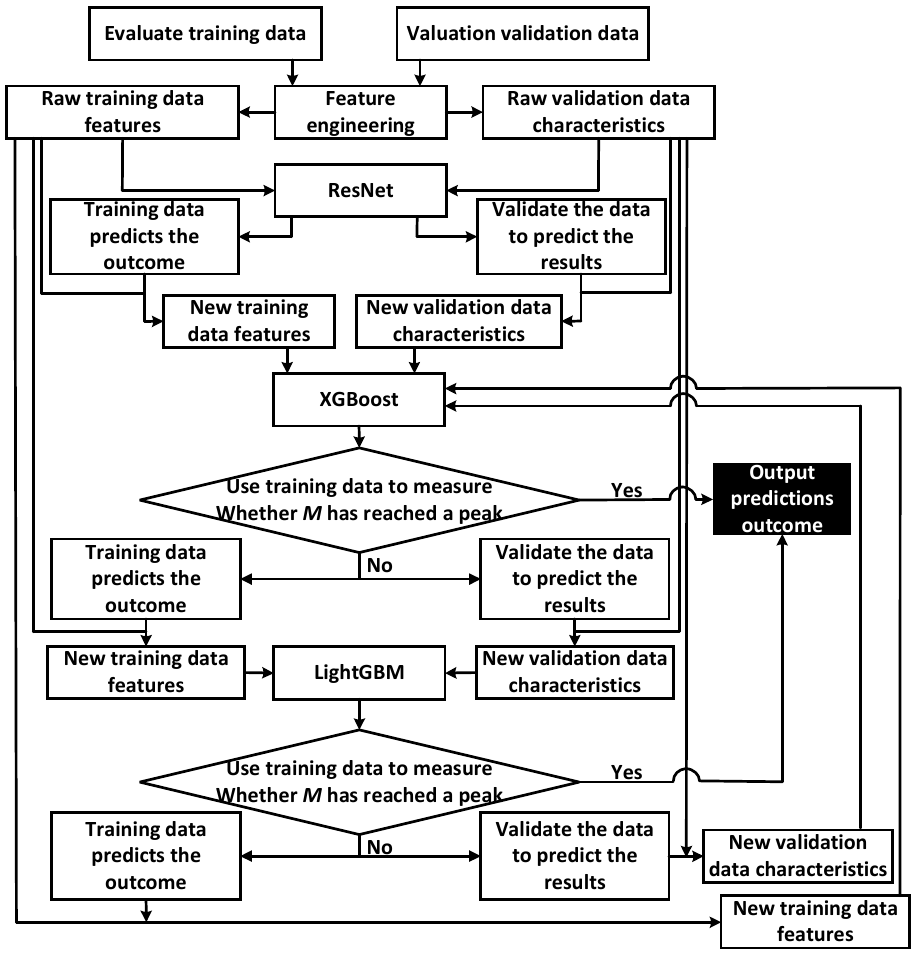
Figure 5. DXL model flowchart.